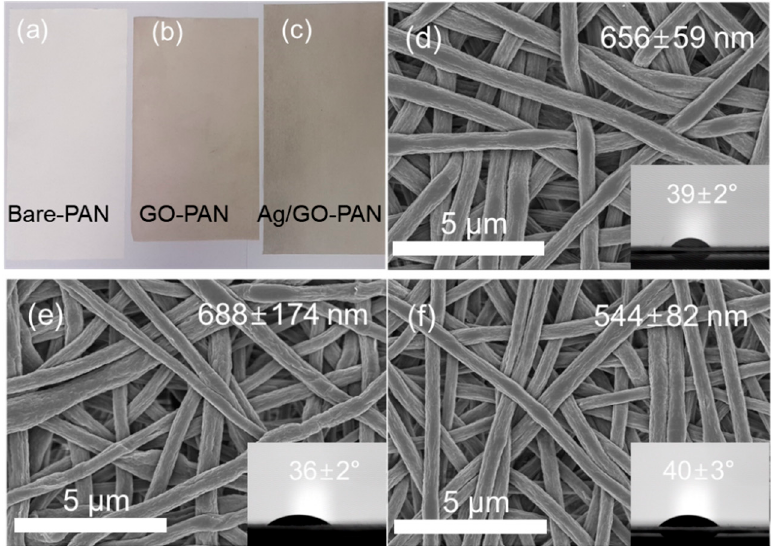
Figure 2. Digital photos ( a – c ), SEM images ( d – f ), and contact angle of nanofiber membrane: ( a ) and ( d ) bare-PAN, ( b , e ) GO-PAN, and ( c ) and ( f ) Ag/GO-PAN nanofiber membranes, where the top right value indicates the average diameter of